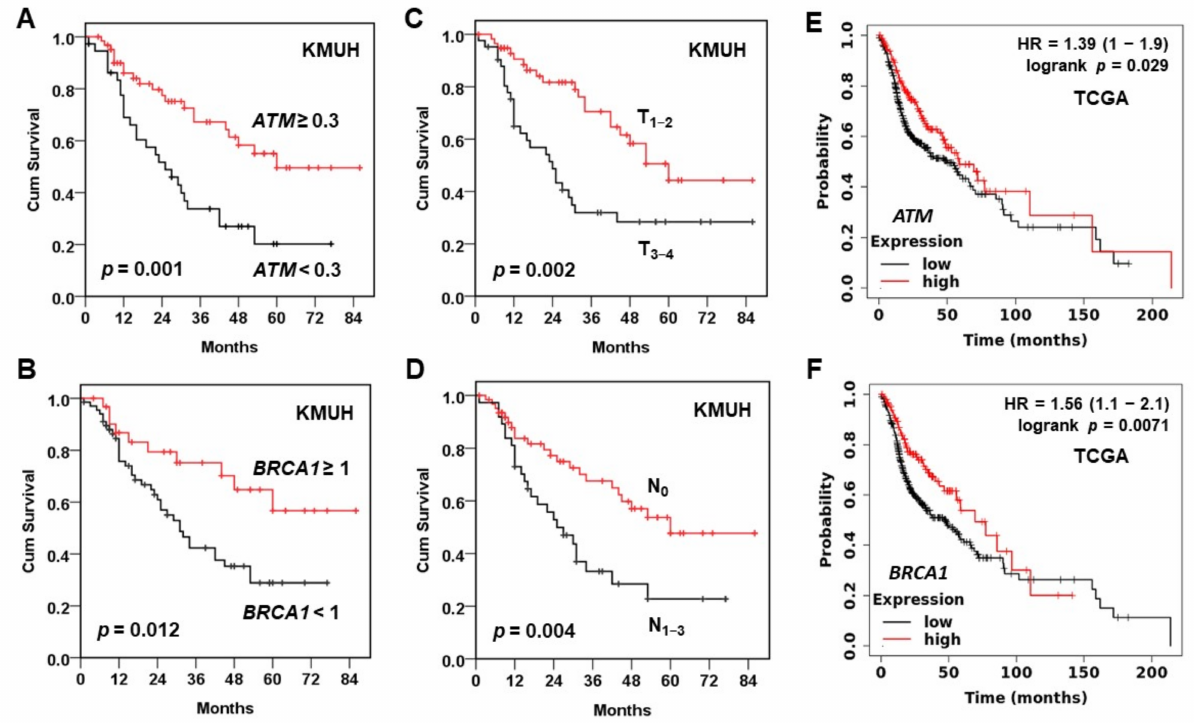
Figure 3. Kaplan-Meier analysis of overall survival (OS). OS curves for ( A ) ATM (<0.3, n = 37; >0.3, n = 63), ( B ) BRCA1 (<1, n = 68; >1, n = 32), ( C ) tumor size (T 1–2 , n = 58; T 3–4 , n = 42), and ( D ) lymph node involvement (N 0 , n = 63; N 1–3 , n = 37) in the KMUH cohort. ( E , F ) OS curves for ( E ) ATM (low, n = 334; high, n = 165) and ( F ) BRCA1 (low, n = 352; high, n = 147) in TCGA cohort were analyzed using Kaplan Meier plotter (http://kmplot.com/analysis/) with the mode of “auto select best